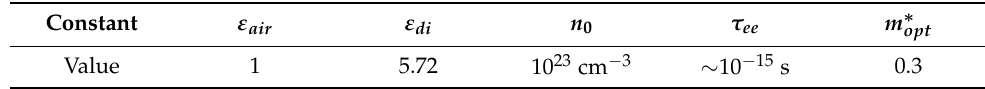
Table 1. The constants value used in this